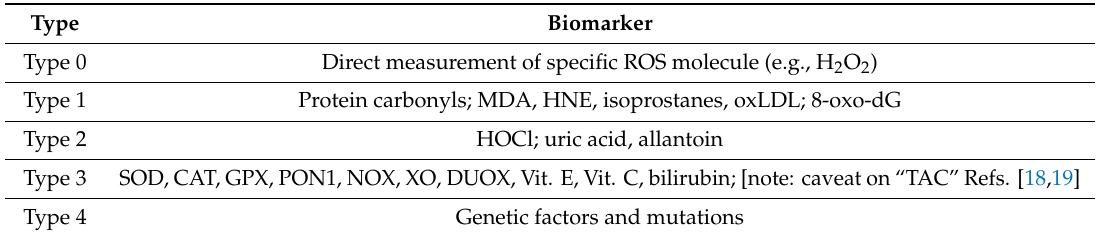
Table 1. Classification of biomarkers related to oxidative stress. Compiled from Ghezzi